Question: What style of plot is this figure drawn as?
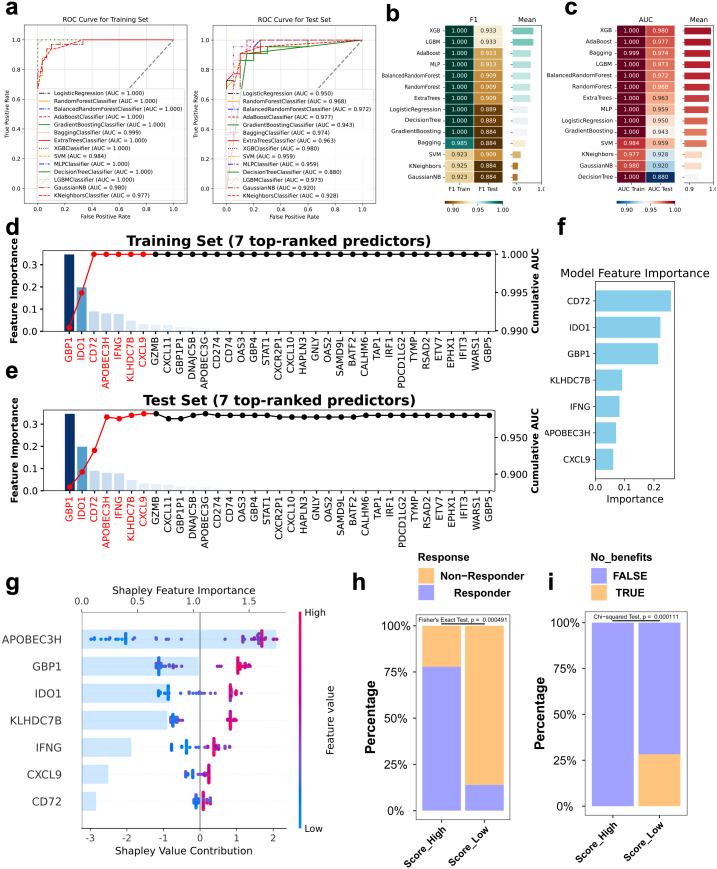
Answer: line